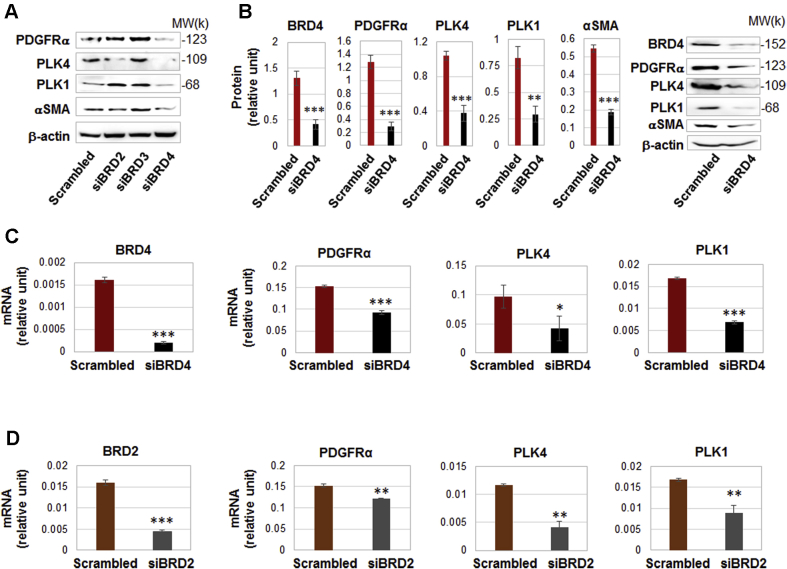
Silencing BRD4 Down-Regulates the Transcription of PLK4 and PDGFRαRat adventitial fibroblasts were transfected with a scrambled or BRD-specific siRNA for 48 hours and collected for (A) Western blot and (B) qRT-PCR assays. (A) Comparison of the effects of silencing BRD2. BRD3, or BRD4 on PLK4 protein levels. Shown are representative blots from 1 of 2 similar repeated experiments. (B) Silencing BRD4 reduces the protein levels of PDGFRα, PLK4, PLK1, and αSMA. Quantification: densitometry normalized to β-actin, mean ± SEM, n = 5 independent experiments, representative blots from one of which are shown on the right. Student t-test: ∗∗p < 0.01; ∗∗∗p < 0.001. (C, D) Effects of BRD4 or BRD2 silencing on mRNA levels of PDGFRα, PLK4, and PLK1 (qRT-PCR data). Quantification: mean ± SD of triplicates; shown is 1 of 2 similar experiments. Student t-test: ∗p < 0.05; ∗∗p < 0.01; ∗∗∗p < 0.001. BRD, bromodomain protein; other abbreviations as in Figures 1, 4, and 11.